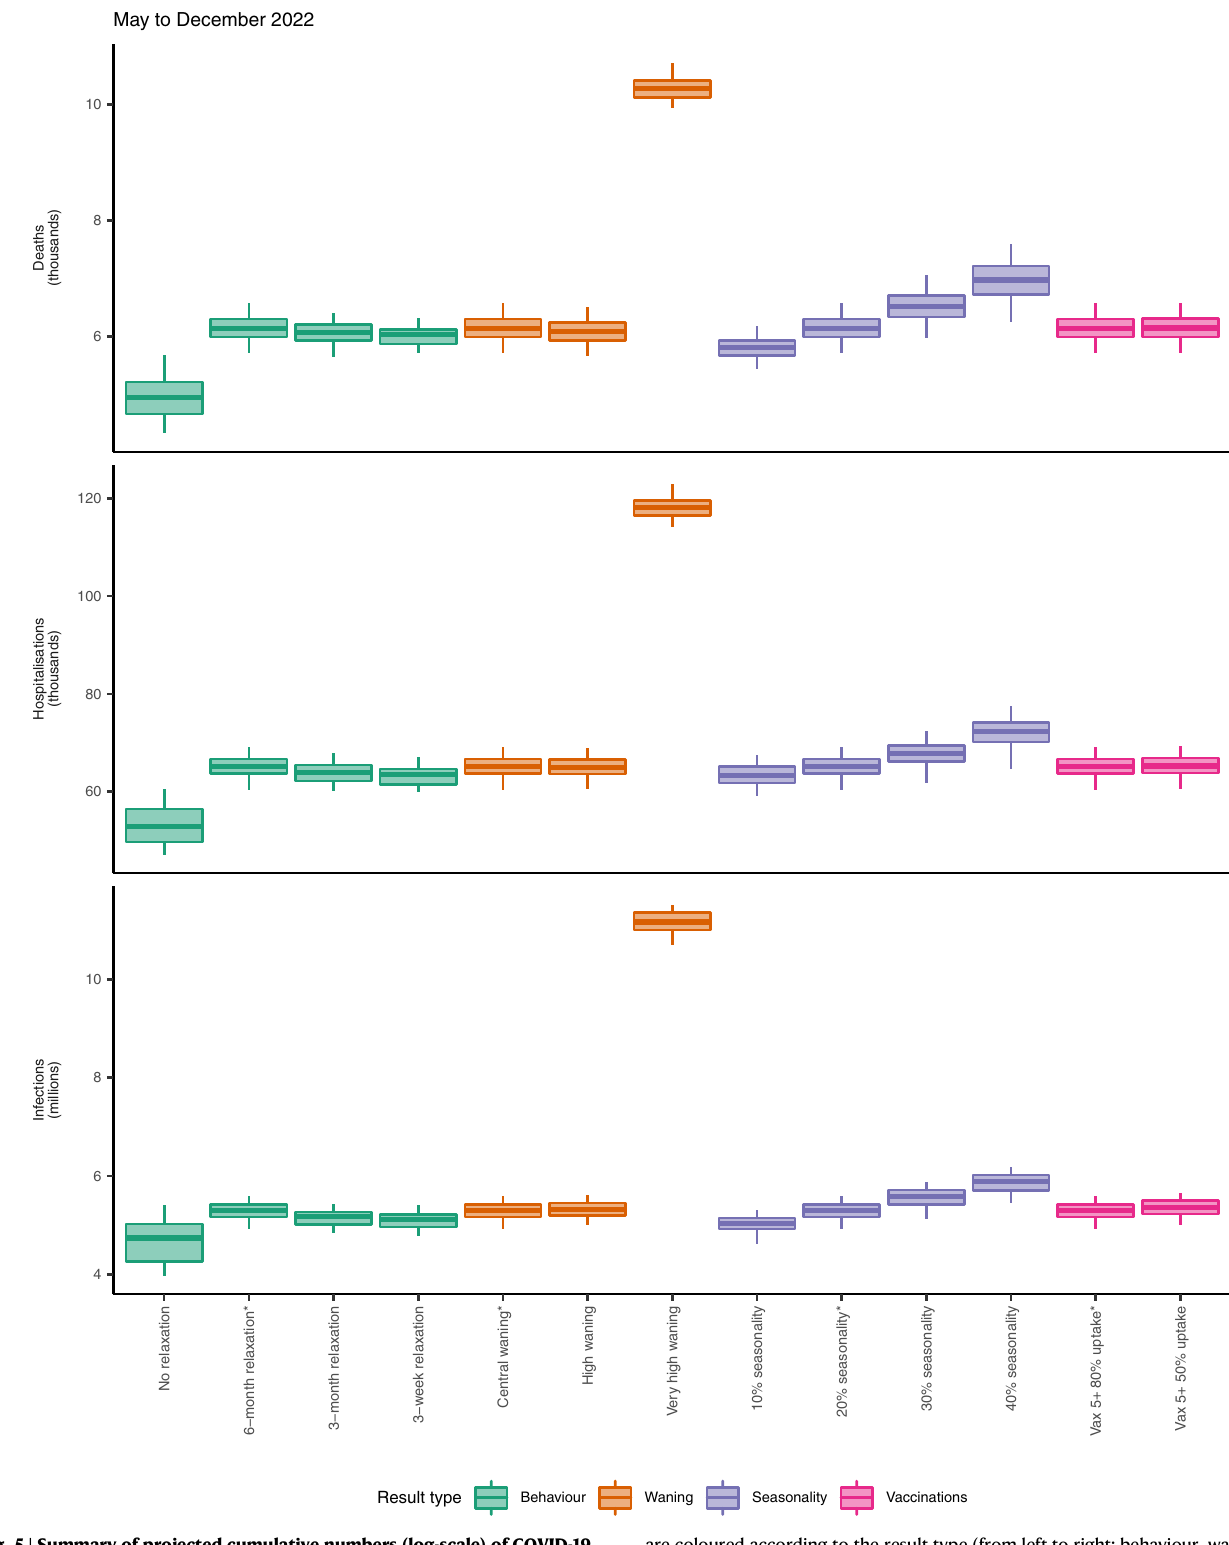
are coloured according to the result type (from left to right: behaviour, waning immunity,seasonality,andvaccinationpoliciesforchildrenaged5yearsandolder). A full list of scenarios and relevant modelling assumptions is given in Table 1. Scenarios marked with an asterisk (*) are equivalent and correspond to the base- case scenario. N.B. The y-axes are plotted on a log scale and are truncated and do not extend to